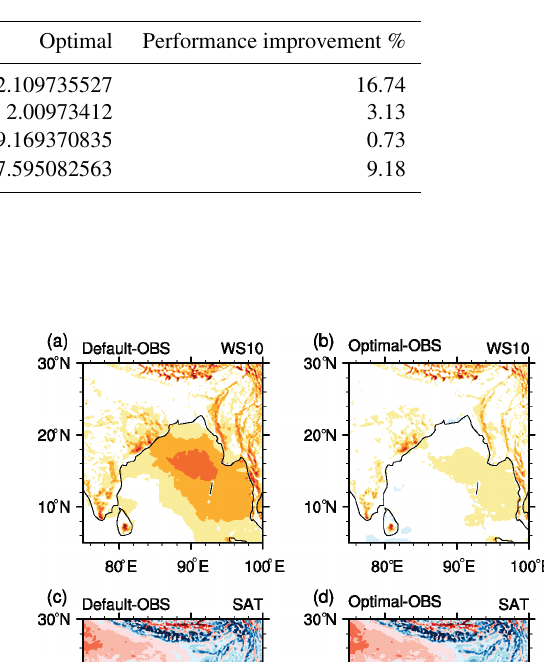
Table 3. RMSE values of variables simulated using default and optimal parameter sets.